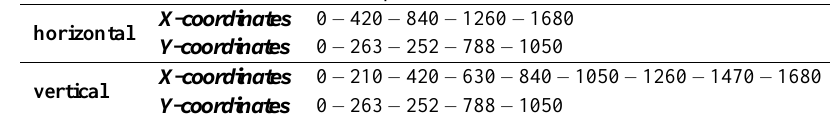
Table 2: Coordinates of the fixation points on the horizontal and vertical stimulus